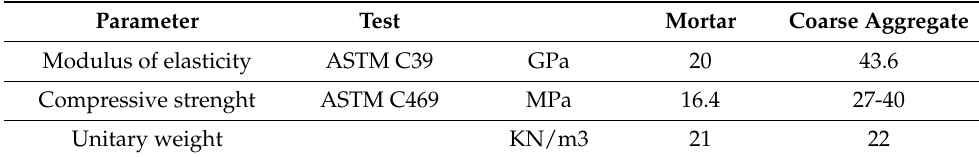
Table 4. Basic properties of working materials.